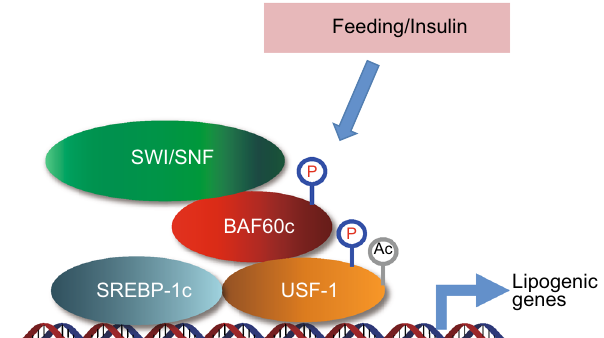
Figure 3. Regulation of insulin-induced lipogenesis by BAF60c in mouse liver. Upon insulin treatment, BAF60c is phosphorylated and translocated to the nucleus, which leads to its direct interaction with phosphorylated/ acetylated USF-1, allowing the recruitment of SWI/SNF chromatin-remodeling complex and transcriptional induction of lipogenic